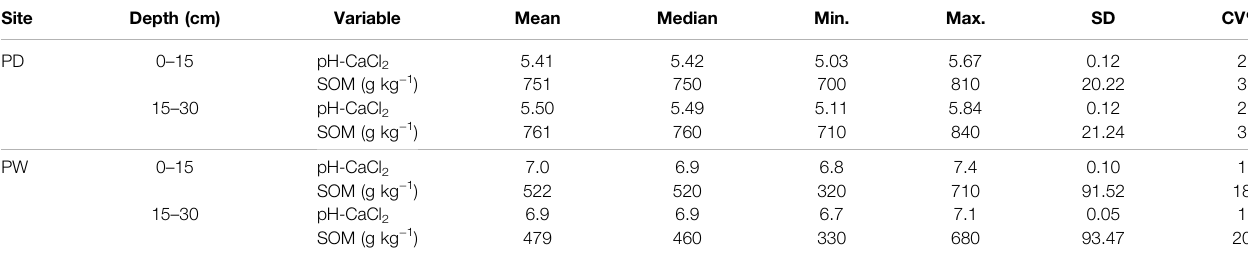
TABLE 1 | The soil pH and organic matter concentrations in the surface and subsurface horizons of the drained and rewetted peatlands. Site Depth (cm)